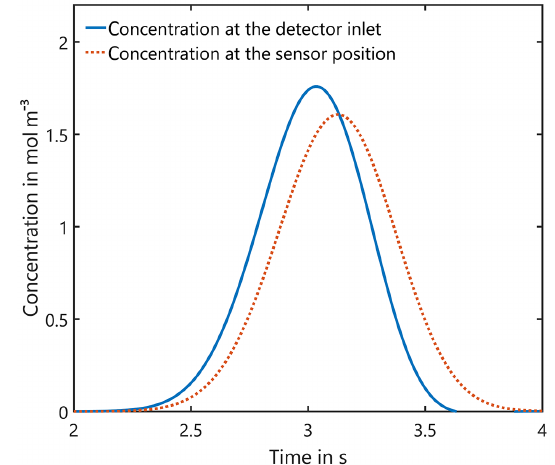
Figure 5. Influence of the detector housing on the shape of incom- ing Gaussian peaks: the peak width of 0.2s at the entrance is in- creased by 8.6% and the maximum concentration is reduced corre- spondingly, but the integral, i.e., the amount of substance, remains